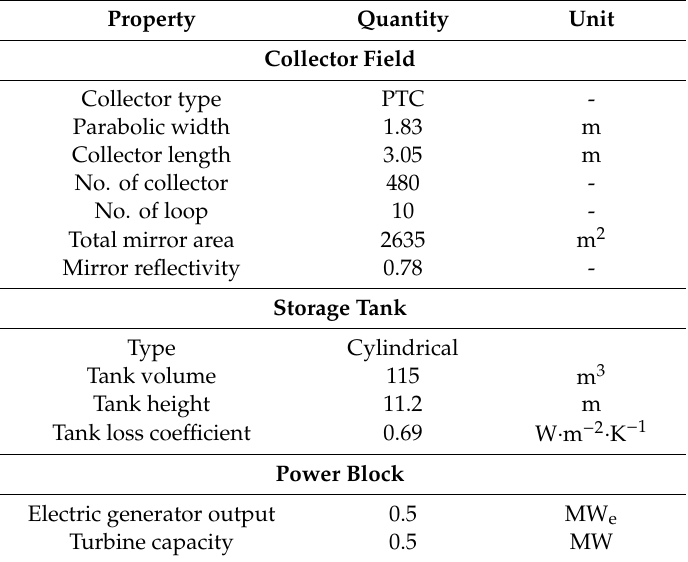
Table 2. Design parameters for solar power.